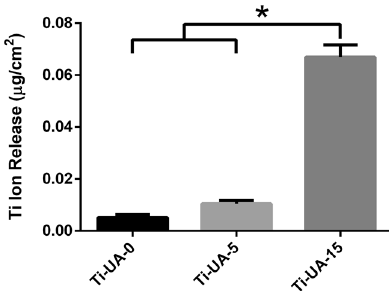
Fig. 6 Total amount of titanium ions released from different samples pre-treated with 0 mg/dL, 5 mg/dL and 15 mg/dL uric acid solution. Results are presented as mean ± SD (* p <